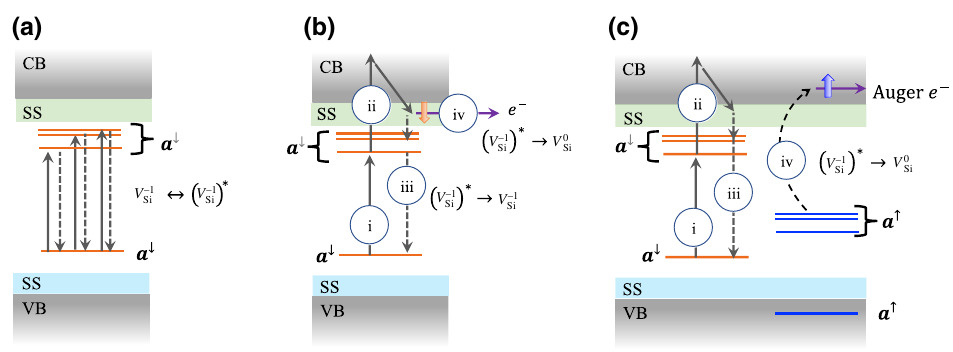
FIG. 4. The optical excitation and charge conversion of V − 1 . (a) A schematic diagram (not to scale) showing the photoexcitation Si → ( V − 1 ) ∗ ] and deexcitation [ ( V − 1 ) ∗ → V − 1 ], resulting in photoluminescence from the V − 1 defect in the NW. Only the filled [ V − 1 Si Si Si Si Si ) ∗ refers to the excited state of the defect. and empty minority-spin defect states (all belonging to the a representation) are shown. ( V − 1 Si The donor- and acceptor-type surface states (SSs) are indicated. (b) A schematic diagram showing the excitation of an excited defect [i.e., i (cid:2) ; followed by ii (cid:2) ] in a two-photon absorption process. Scattered into the localized acceptorlike surface state, the electron can → V 0 either undergo phosphorescence [marked as iii (cid:2) ], resulting in blinking, or it can migrate away from the defect, resulting in a V − 1 Si Si charge conversion, with the latter being a dark state. (c) A schematic diagram showing another possible route to charge conversion to the neutral state, involving a two-photon absorption process [ i (cid:2) followed by ii (cid:2) ] followed by an Auger process [marked by iii (cid:2) and iv (cid:2) ] that ionizes the defect. Here, the filled majority spin states are also shown because the spin-up electron is ionized from the defect. VB and CB stands for valence and conduction bands,